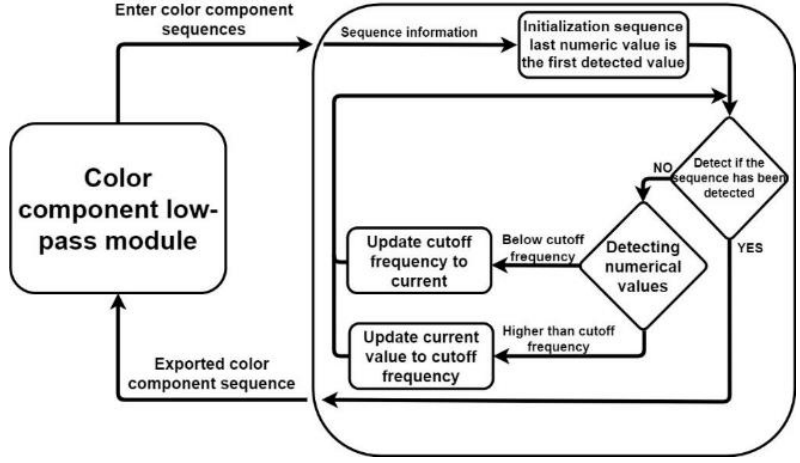
Figure 15. Architecture of the developed CCLPF module.